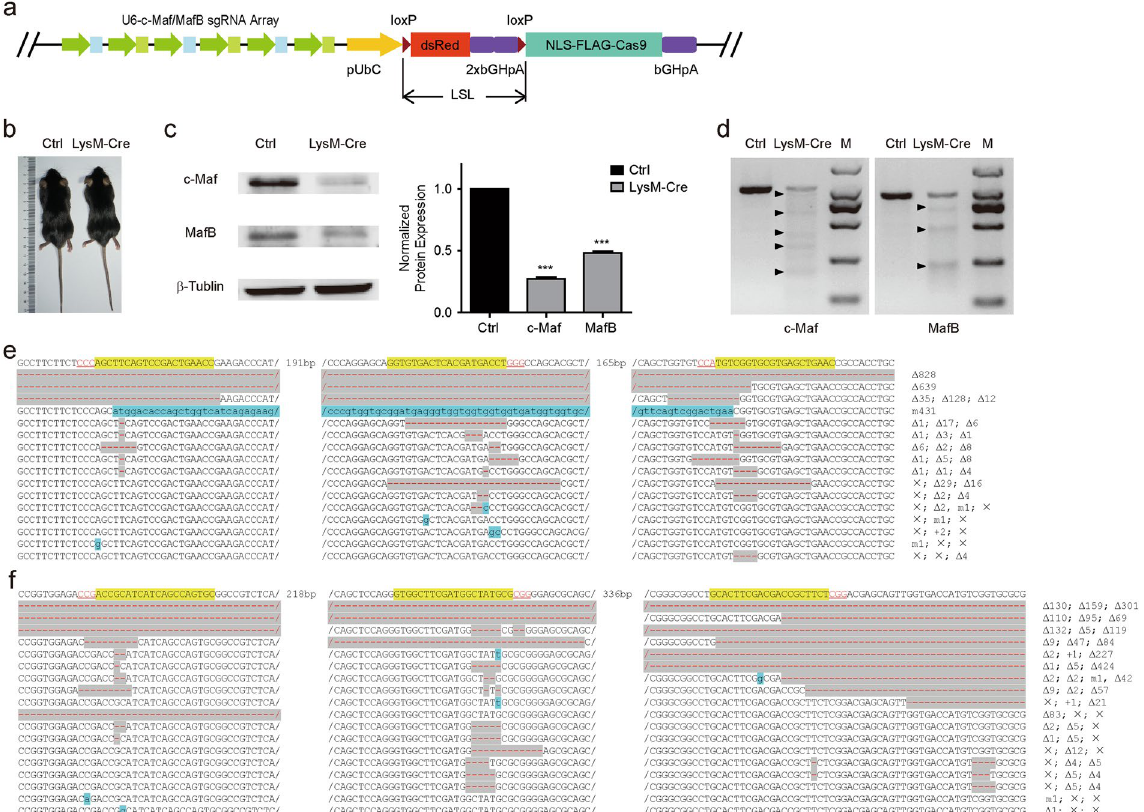
Figure 3. c - Maf/MafB double cKO via sgRNAs-LSL-Cas9 system. ( a ) Schematic of transgenic vector sgRNAs c - Maf/MafB -UbC-LSL-Cas9. Three U6 promoters (green arrowheads) driven c - Maf sgRNAs (blue blocks) and three U6 promoters driven MafB sgRNAs (green blocks) were arranged alternately. Other functional regions are combined as those in the sgRNAs EGFP -UbC-LSL-Cas9 transgenic vector (Fig. 1a). ( b ) Photograph of sgRNAs c - Maf/ MafB - UbC - LSL - Cas9 mice. Ctrl, transgenic mouse without Cre. LysM-Cre, transgenic mouse express lysM-Cre. ( c ) Western blots of c - Maf/MafB double cKO macrophages (paired t-test, c-Maf, *** p = 0.003, n = 3. MafB, *** p = 0.0009, n = 3). ( d ) T7EN1 analysis of c - Maf and MafB mutations in the macrophages of a sgRNAs c - Maf/ MafB - LSL - Cas9 ; LysM - Cre (LysM-Cre) mouse. The control (Ctrl) was a sgRNAs c - Maf/MafB - LSL - Cas9 mouse without Cre recombinase. M, marker. ( e ) c - Maf mutation mode of the Cre-expressing macrophages of the transgenic mouse. ( f ) MafB mutation mode of the Cre-expressing macrophages of the transgenic mouse. + ,